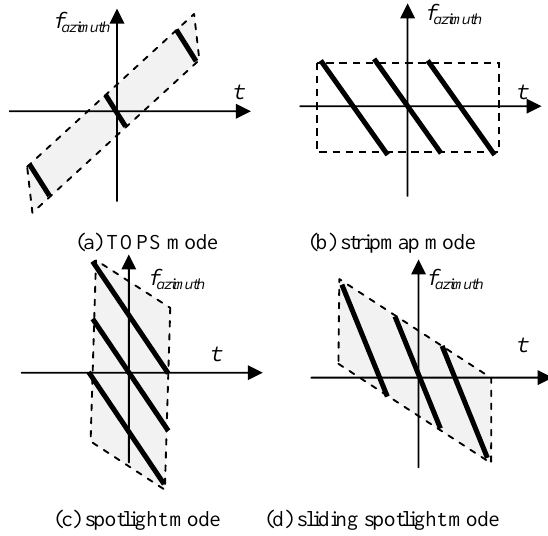
Figure 5.The Doppler time-frequency diagram of SAR modes